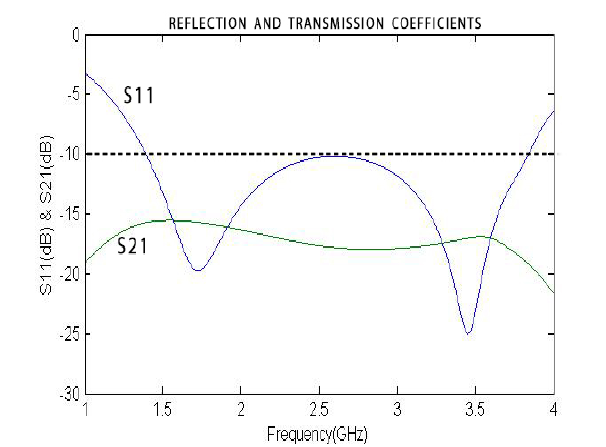
Figure 5: Simulated Reflection and transmission coefficient of antenna with split ring